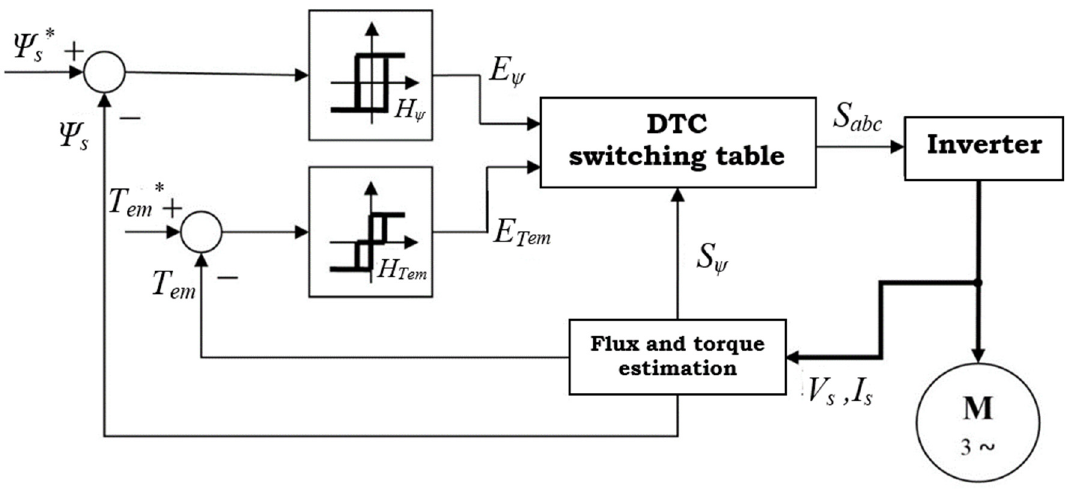
∗ and T ψ and * em * are the reference flux and the reference electromagnetic T are the reference flux and the reference electromagnetic torque. Figure 1. The DTC basic scheme. ψ s s em